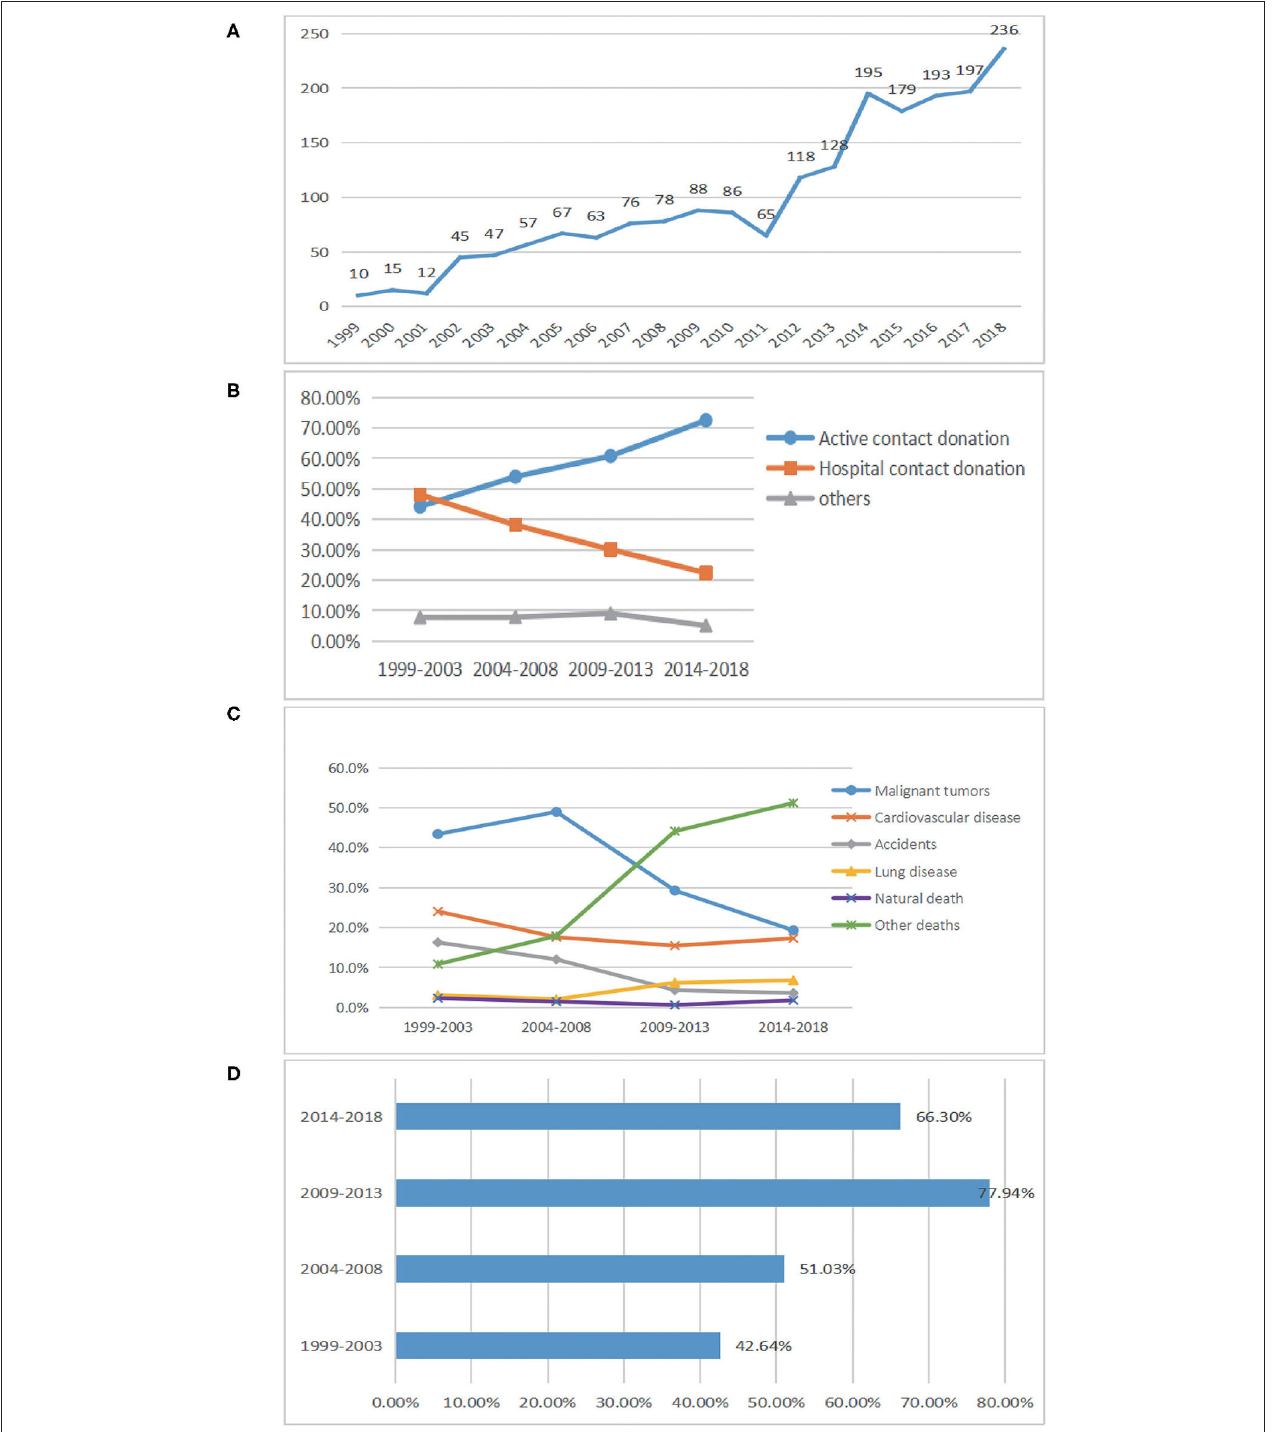
FIGURE 3 | Eye banking from 1999 to 2018. (A) The number of actual donations from 1999 to 2018. (B) Corneal access channels of the 1,955 actual donors. The corneal access channels included donors or their families who actively contacted the eye bank (active conduct donation), donors or their families that were contacted by the eye bank through hospitals (hospital contact donation), and others (e.g., funeral services and nursing homes). Of these donors, 1,904 (97.4%) were from Chongqing, and 51 (2.6%) came from other regions in China (refer to details in Figure 2B ). (C) Causes of donor deaths. Accidents such as car accidents, electric shock, drowning, falling from a building, burns, and sudden death are classified as accidental injuries; deaths caused by other diseases, suicide, and unexplained death are classified as others. Lung disease excluded lung cancer. (D) The corneal utilization rate in each subperiod. The corneal utilization rate of the 2,540 eventually used for transplantation in each subperiod (1999–2003, 2004–2008, 2009–2013, and 2014–2018).